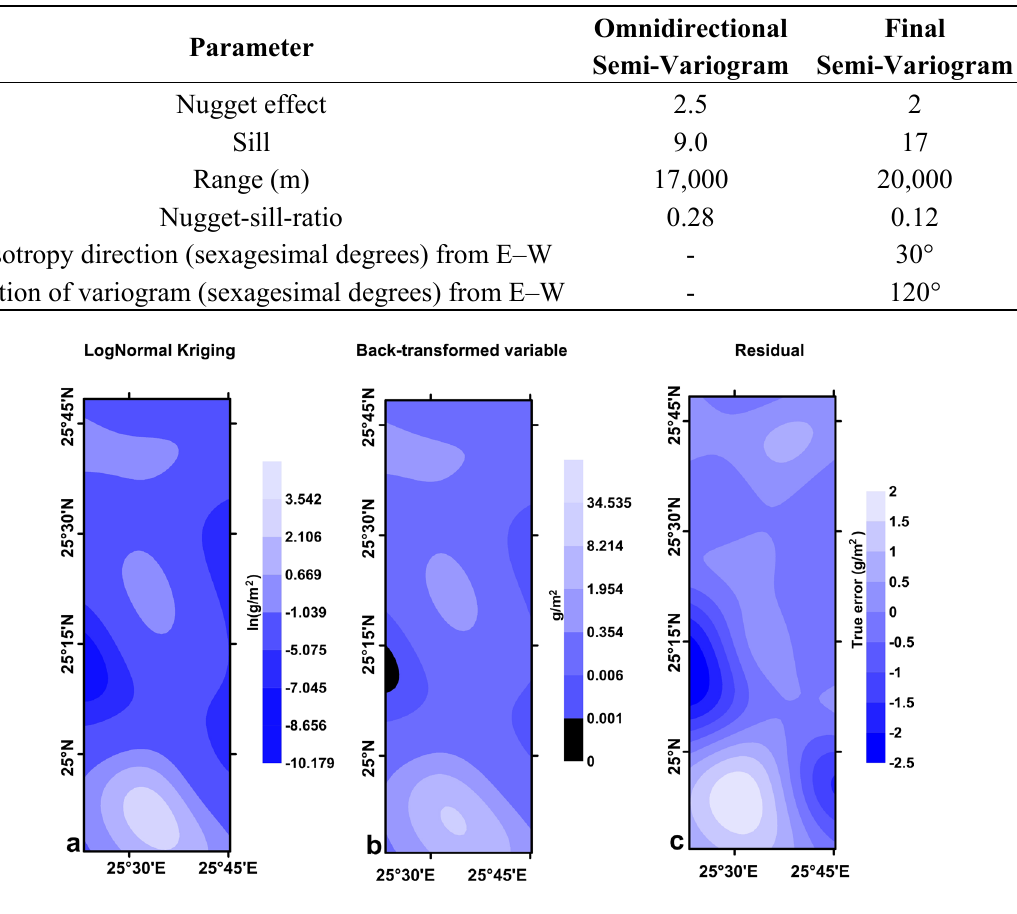
Figure 9. Contour maps of ( a ) the log-normal kriging, established with a 150° directional semi-variogram; ( b ) back-transformed variable with Yamamoto’s method; and ( c ) the residuals or error quantification of the back-transformed